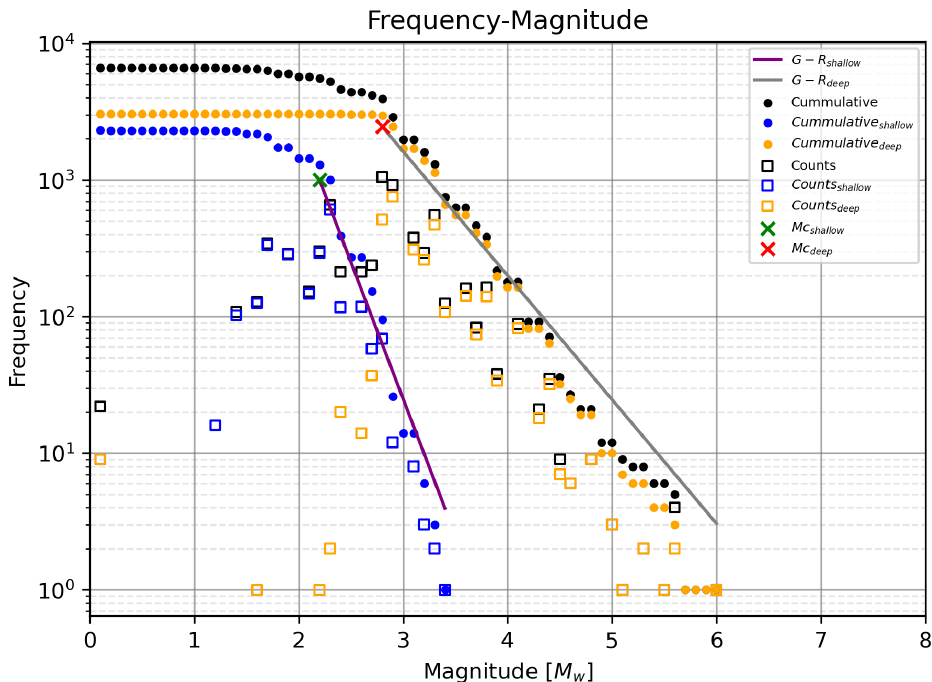
Figure 12. Frequency-magnitude plot for the full catalog (black), shallow events ( < 50km depth) and deep events ( > 50km). The counts are shown with open square markers and the cumulative representation in closed dots. The G–R law has been fitted for both the deep events and shallow events